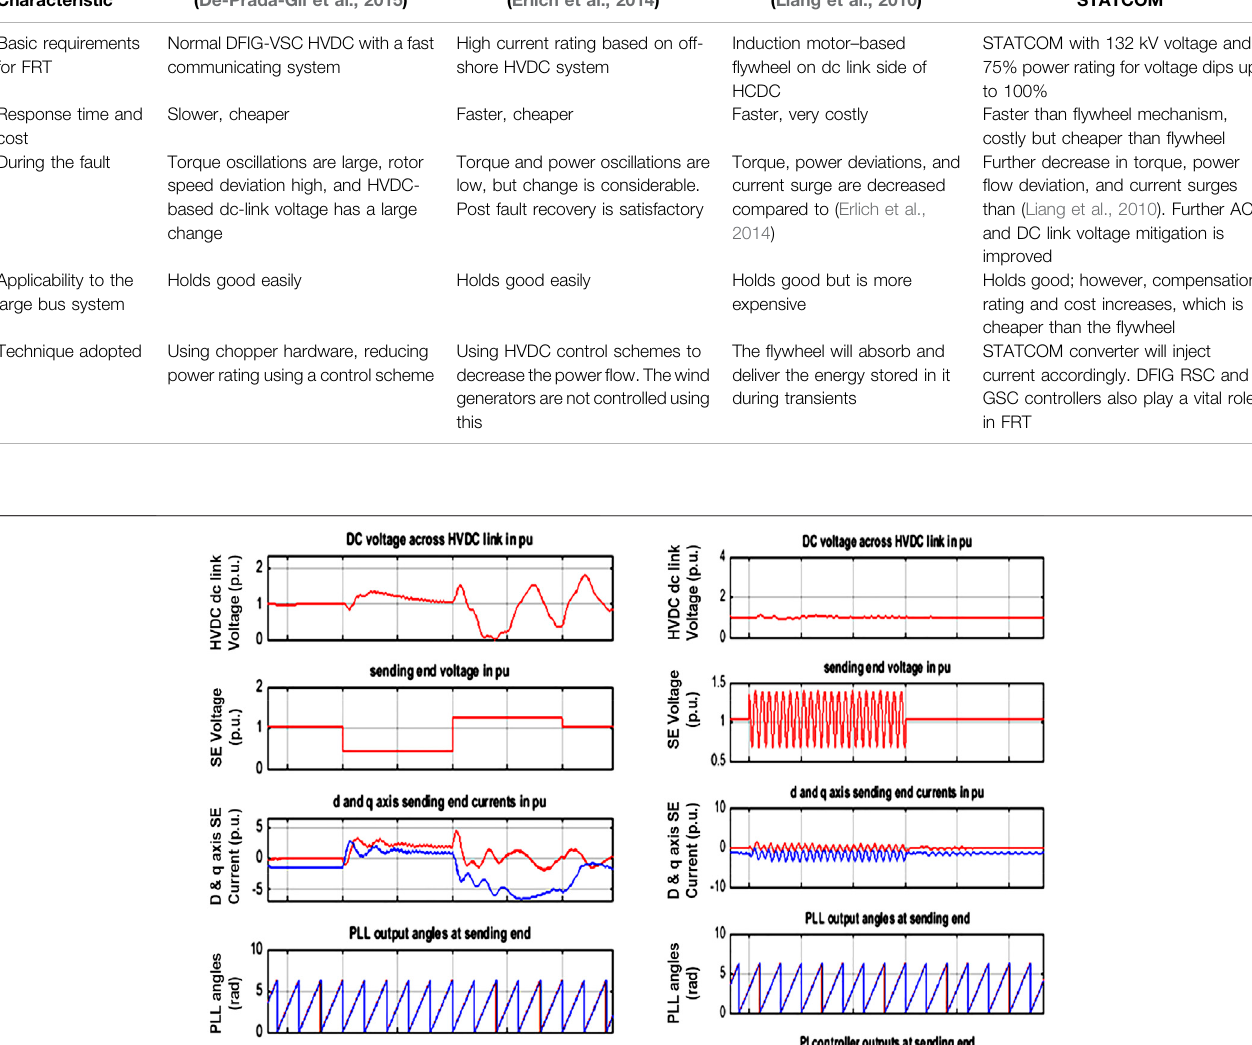
TABLE 3 | Comparison of various DFIG HVDC VSC based fault ride through strategies. Strategy Characteristic